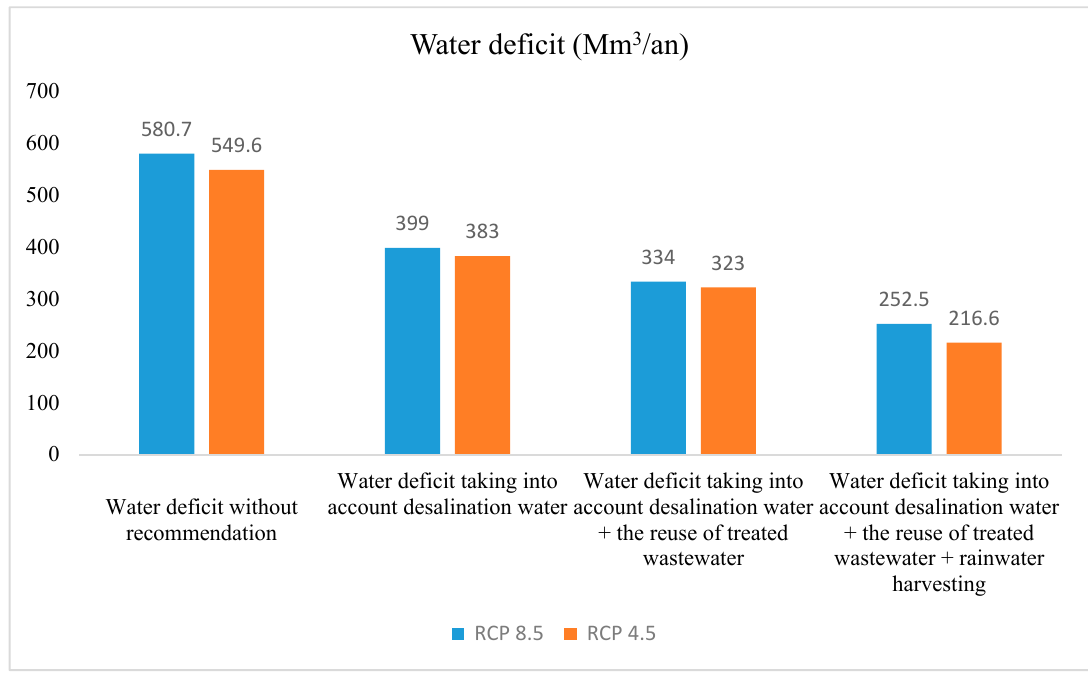
Figure 10. Impact of the use of unconventional water resources on the water balance in the Souss–Massa region [42].